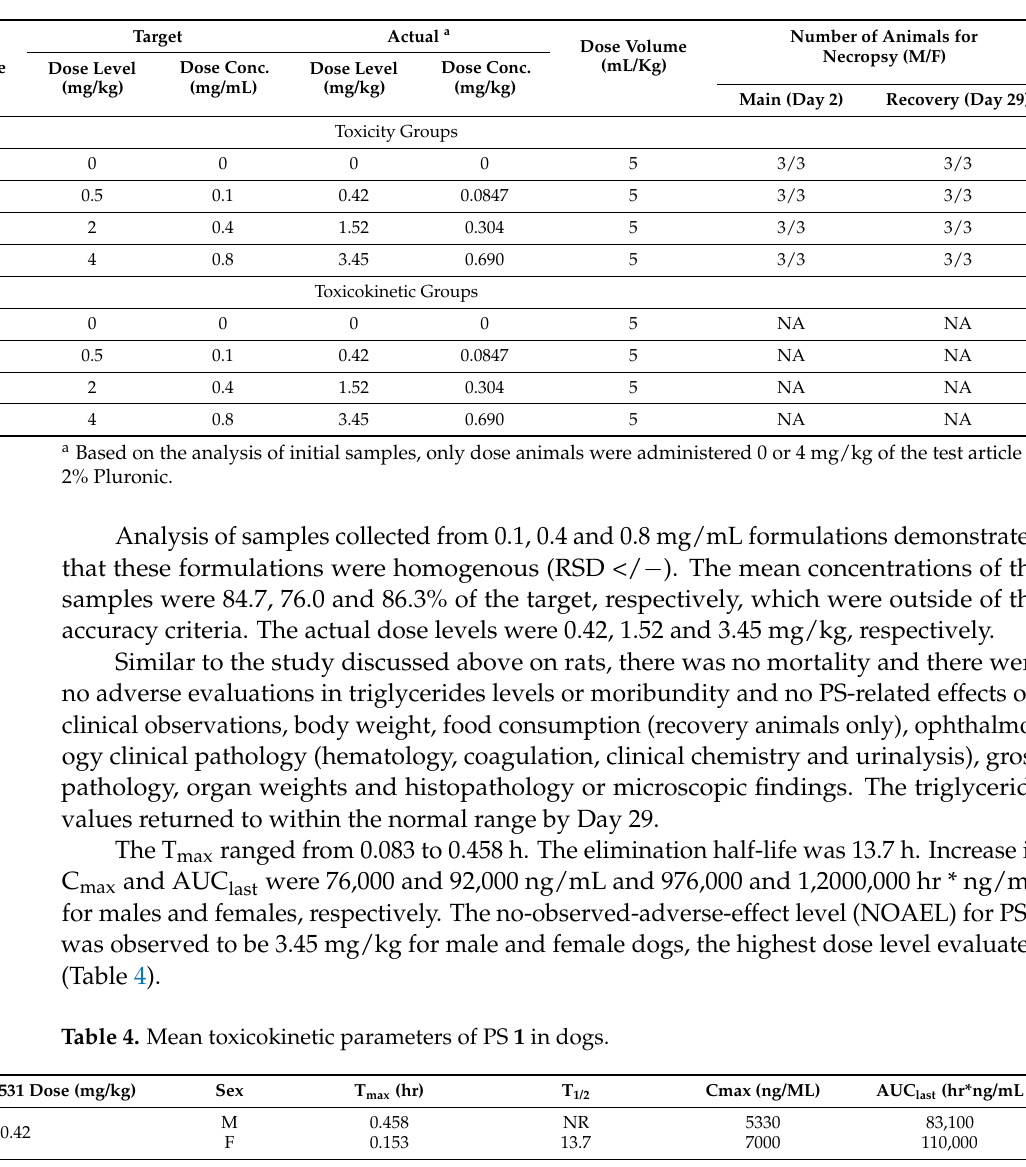
Table 3. Group assignments and dose levels (dog study).